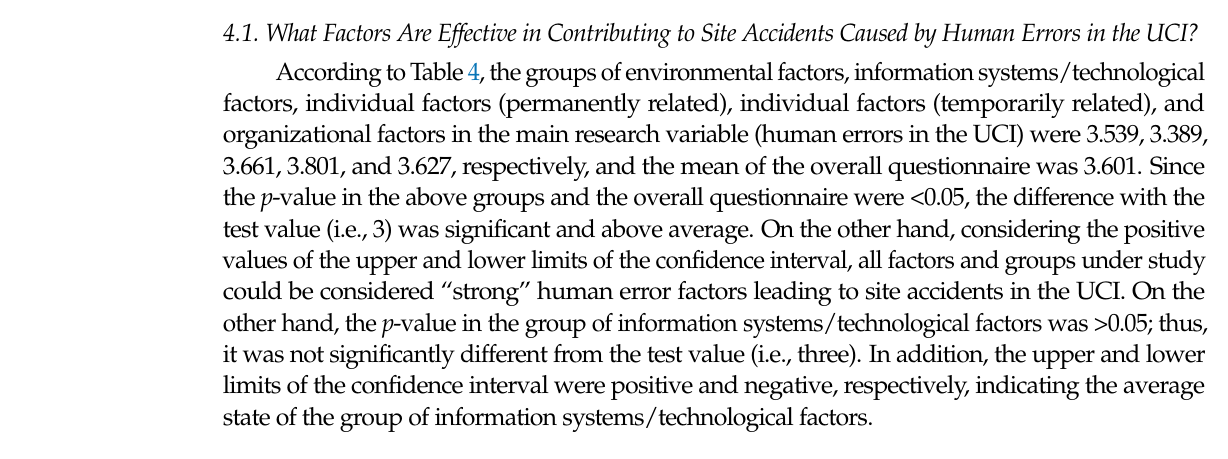
Table 4. Results of one-sample t -test for human error factors in the